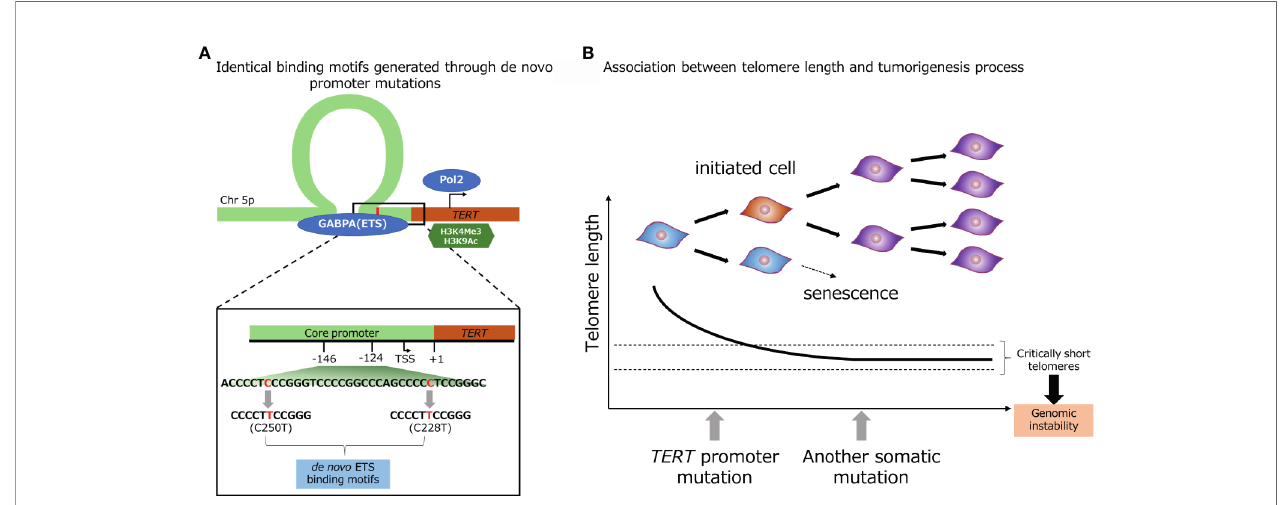
FIGURE 2 | Identical de novo binding motifs generated through promoter mutations (A) . Schematic representation of TERT promoter mutation. Association between telomere length and tumorigenesis process (B)